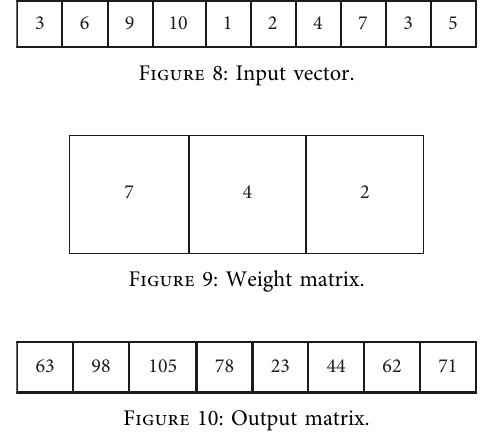
Figure 10: Output